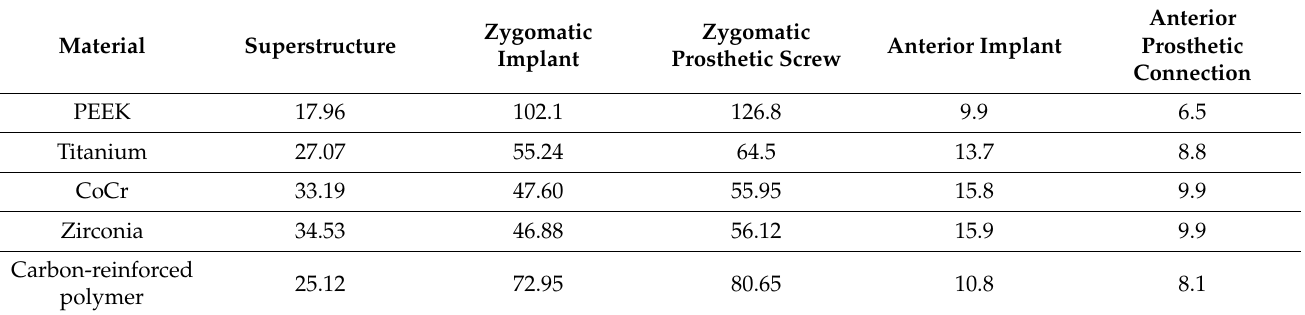
Table 2. Stress peak calculated in each